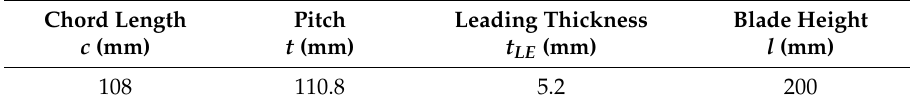
Table 2. The leading edge deformations and naming method Table 1. The physical parameters of the cascades.